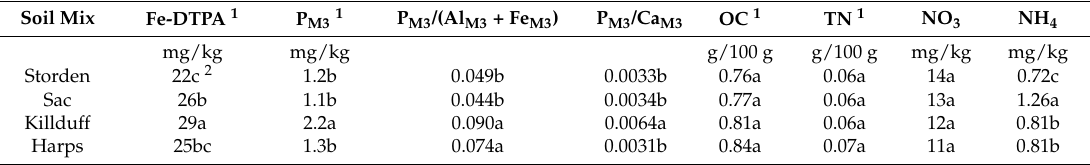
Table 2. Properties of soil mixes averaged across those with and without compost blankets. Soil